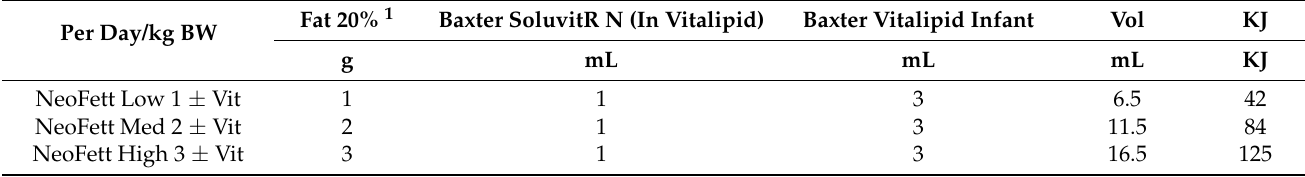
Table 4. ‘NeoFett’ solutions, containing fat and vitamins, supply per kg bodyweight per day.